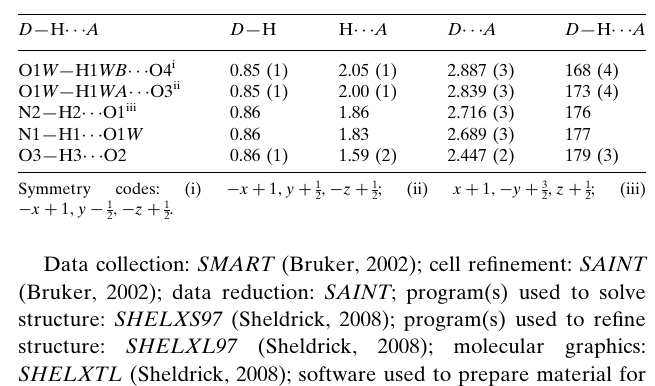
Hydrogen-bond geometry (A˚ , (cid:2)